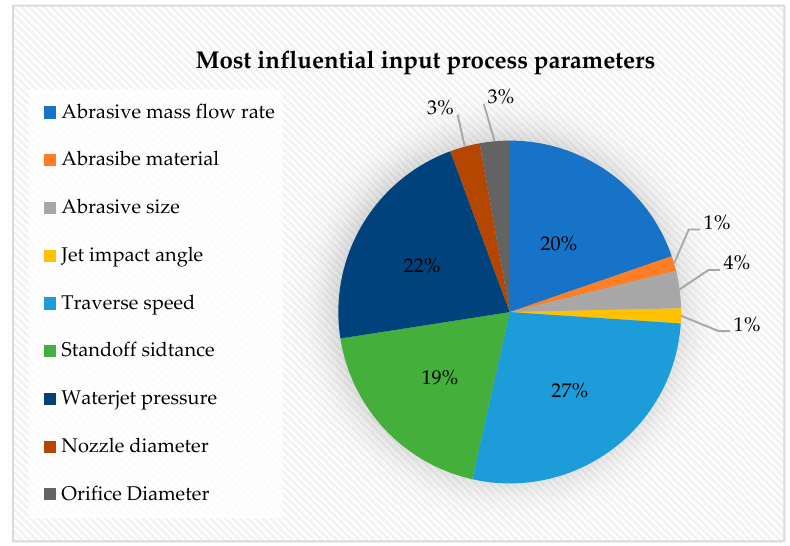
Figure 6. Survey of identified most influential AWJ cutting input process parameters reviewed publications from 2017 to 2020 [25–66].